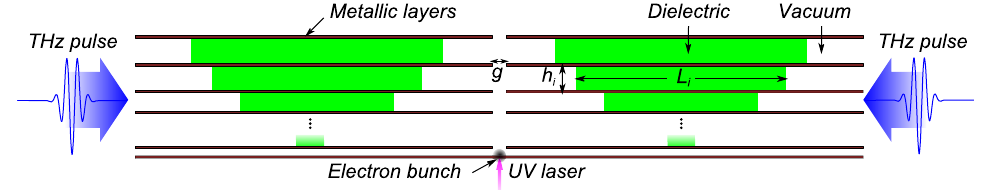
FIG. 6. Schematic illustration of the high-energy ultrafast gun concept.